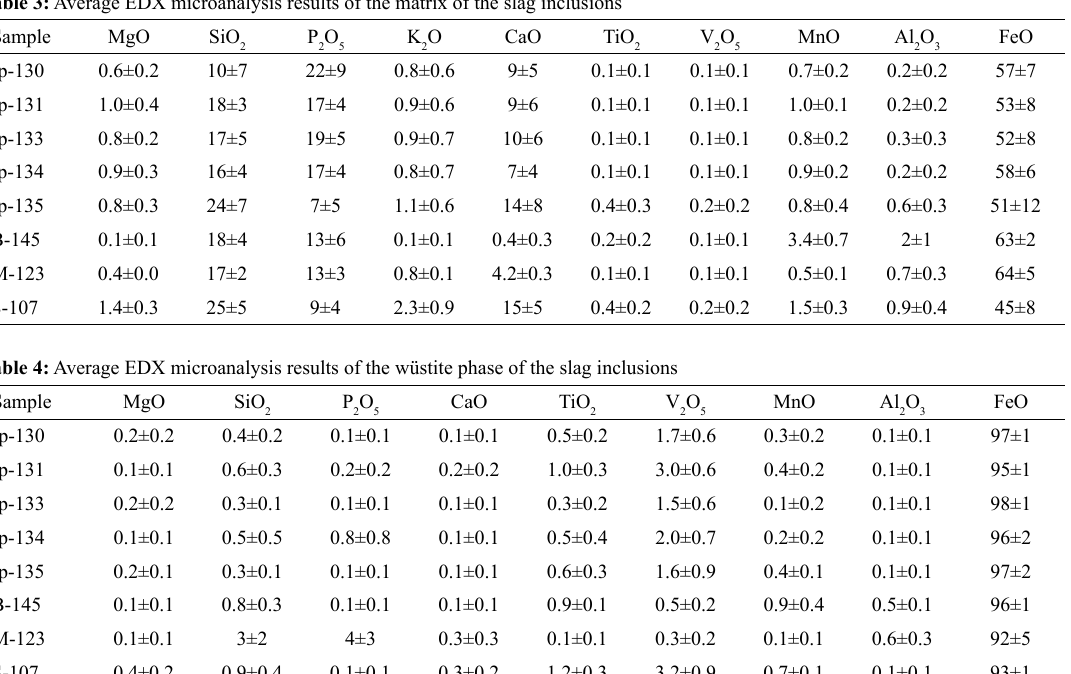
O; (c) %Al O versus % MgO; and d) %FeO versus %SiO 2 2 3